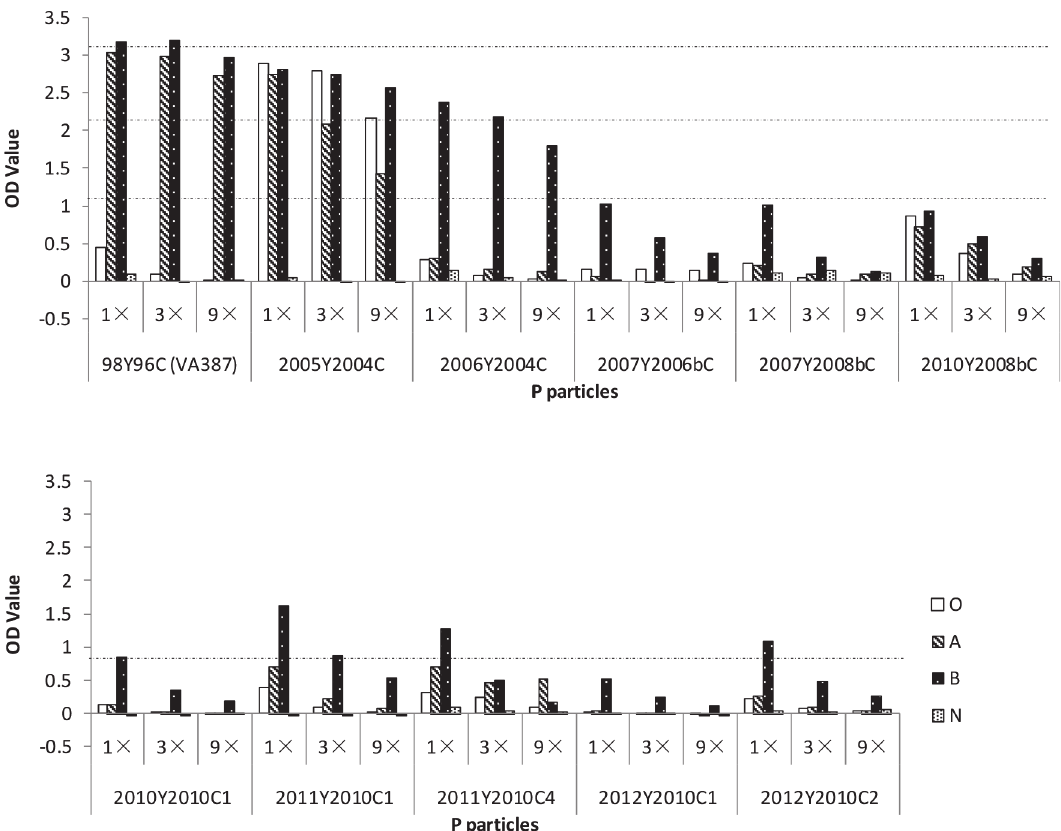
Fig 3. Binding of GII.4 P particles to human saliva samples. Boiled saliva samples were coated onto 96-well plates prior to the addition of P particlesfrom ten GII.4 viruses expressed in this study (2005Y2004C, 2006Y2004C, 2007Y2006bC, 2007Y2008bC, 2010Y2008bC, 2010Y2010C1, 2011Y2010C1, 2011Y2010C4, 2012Y2010C1, and 2012Y2010C2). The P particles were tested in a series of 3-fold dilutions by enzyme-linked immunosorbent assay (ELISA) (optical densities at 450 nm were averaged from at least three independent experiments) and the 98Y96C (VA387) P particle was set as the positive control for binding. “ O, ” “ A, ” “ B, ” and “ N ” represent the type O (H antigen), A, B, and nonsecretor saliva,